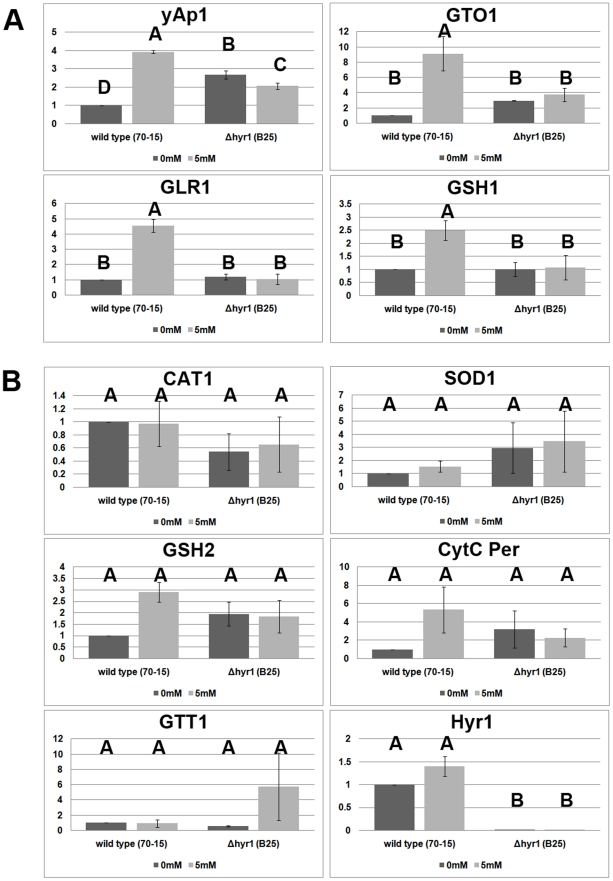
Antioxidant gene orthologs have altered expression in the
Δhyr1 mutant versus wild type.Wild type (70-15) and Δhyr1 mutant (B25) were grown
in 0 mM and 5 mM hydrogen peroxide and collected 1 hour after immersion.
RNA was extracted and real-time qRT-PCR performed on three biological
replicates. (A) The YAP1,
GTO1, GLR1 and
GSH1 all increase in expression in wild type upon
H2O2 challenge, but the latter three display
low levels in the mutant. (B) CAT1,
SOD1, GSH2, GTT1
and cyt c peroxidase do not display significant changes
in expression. MoHYR1 expression is abolished in the
mutants. Letters over bars represent statistically significant
differences between expression changes of the genes (statistics were
generated using student t-test with p-value <0.05).